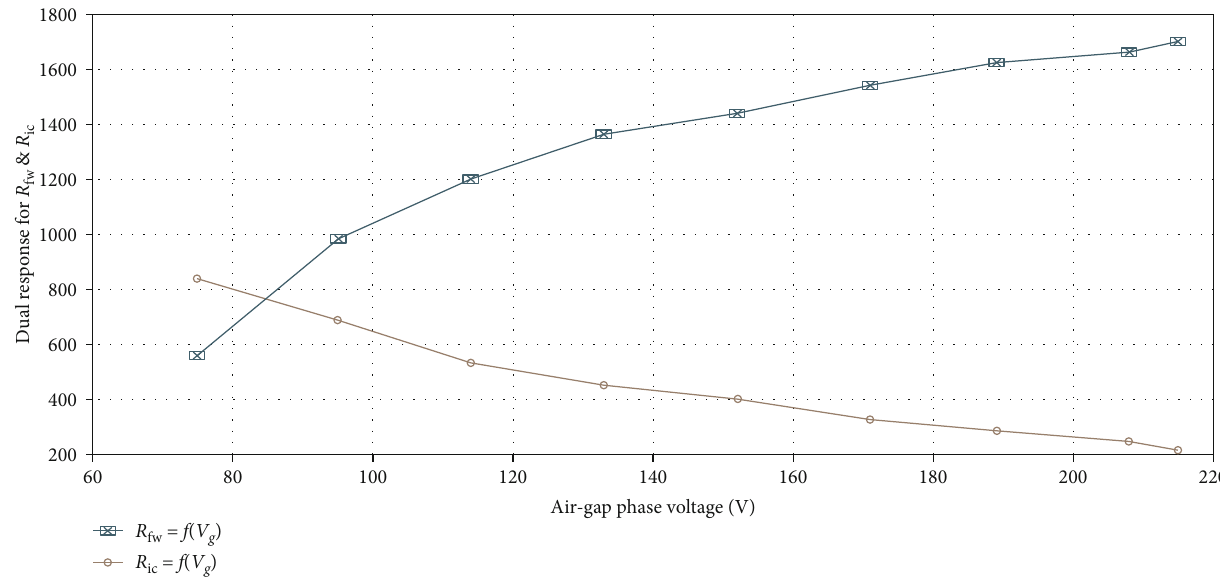
Figure 2: Variation of iron core and mechanical loss resistances with air-gap